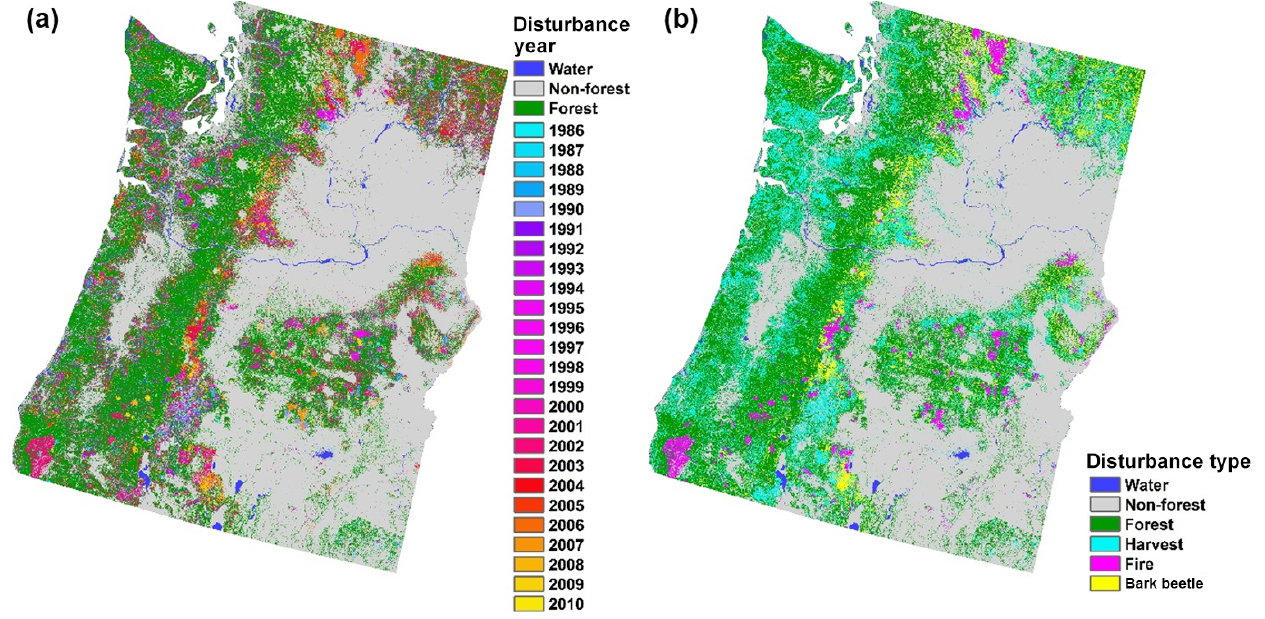
Figure 5. Maps of (a) disturbance year and (b) disturbance type integrated from NAFD (Fig. 1a), MTBS (Fig. 1b), and ADS (Fig. 1c) data in the PNW region. NAFD: North American Forest Dynamics, MTBS: Monitoring Trends in Burn Severity, ADS: aerial detection